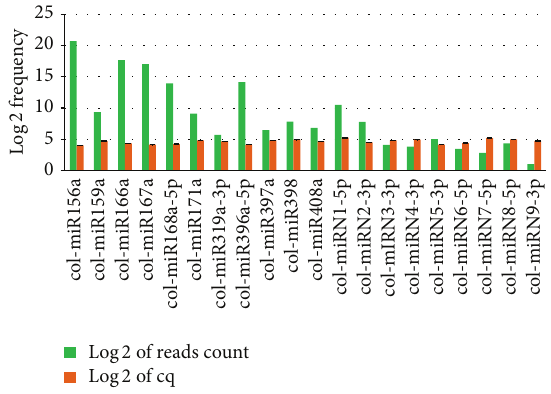
Figure 6: Comparative expression analysis of different selected miRNAs found by deep sequencing and qRT-PCR. Read counts of deep sequencing and cq values of qRT-PCR were converted into log 2 value for a better representation. Here the green bars represent log 2 values of sequencing frequency and orange bars represent the log 2 values of cq produced by qRT-PCR. Black regions on top of the orange bars represent errors calculated as standard